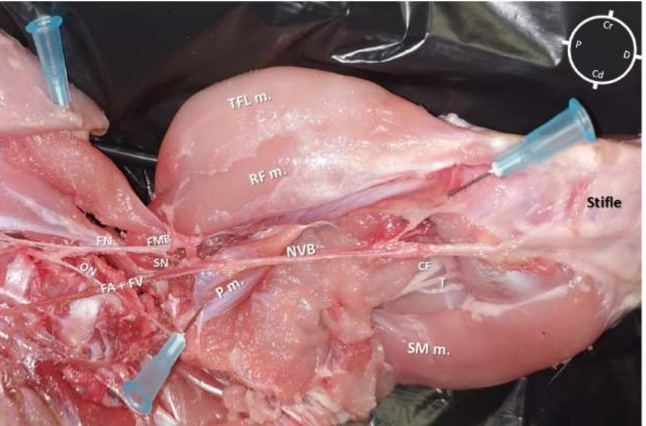
Figure 3. Skinned rabbit hind-limb positioned in dorsal recumbency with the hind-limb extended in a natural position after blunt dissection of the medial aspect of the left thigh and removal of the vastus medialis, sartorius, gracilis, and adductor muscles. The femoral nerve is observed leaving the psoas compartment and, at the level of the inguinal crease, giving origin to a motor branch that runs into the muscles located in the anterior aspect of the thigh and to the saphenous nerve, which joins into the same fascia of the femoral artery and vein forming the neurovascular bundle (NVB). This bundle runs medial and caudal to the femur, caudal to the vastus medialis, rectus femoris (RF m.), and tensor fascia latae (TFL m.) muscles, cranial to the adductor, semimembranosus (SM m.), and gracilis muscles and below the sartorius muscle. P: Proximal; D: Distal; Cr: Cranial; Cd: Caudal; FN: Femoral nerve; ON: Obturator nerve; SN: Saphenous nerve; FA + FV: Femoral artery + Femoral vein; FMB: Femoral motor branch; P m.: Pectineus muscle; CF: Common fibular nerve; T: Tibial nerve.